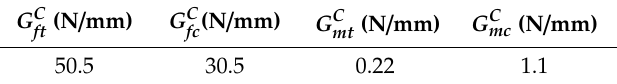
Table 4. Composite material fracture energy parameters [8].